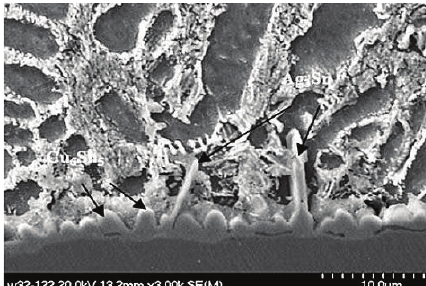
Figure 9: The microstructure of IMC layer at the interface between solder and copper [83].